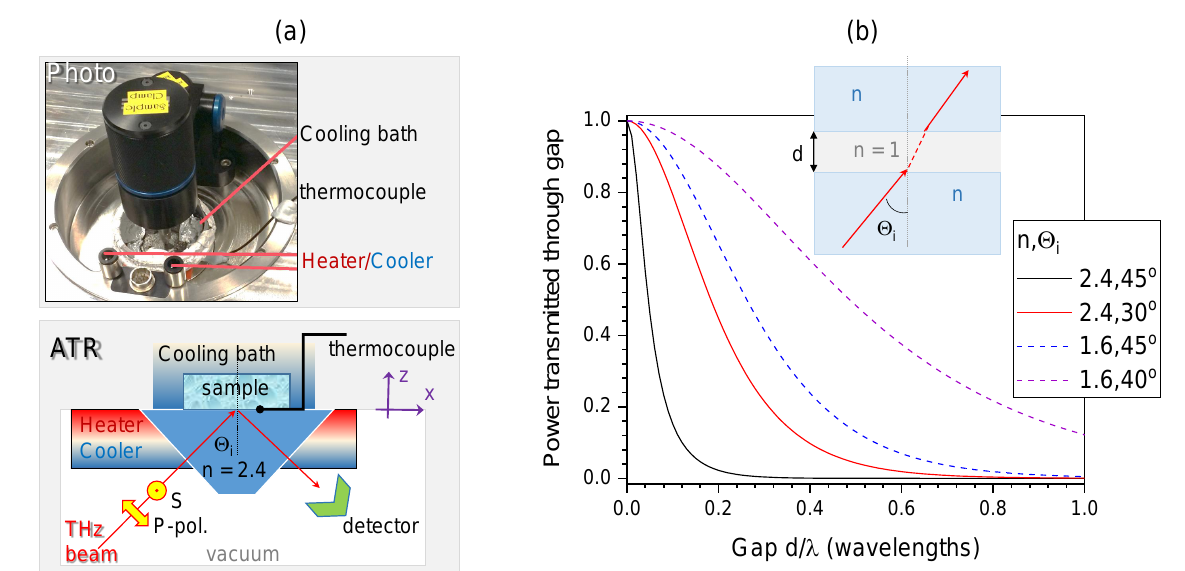
Figure 1. ( a ) Photo and schematics of ATR setup used for temperature dependent absorbance spectroscopy at the THz/Far- IR beamline [15,16]. ( b ) Visualisation of frustrated TIR (Equation (2)) for different angles of incidence and refractive indices n of the slabs. The index n = 1.6 also corresponds to the case when two n = 2.4 (diamond) slabs are separated by n gap = 1.5 = 2.4 = (bio-sample), i.e., n n gap 1.5